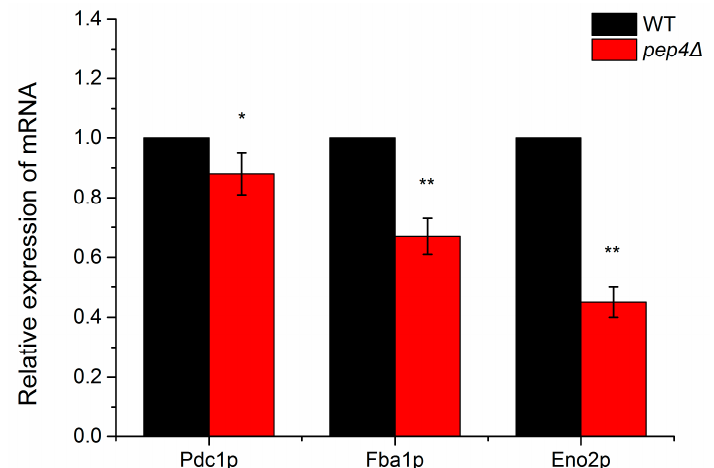
291 Figure 3. Relative mRNA expression levels of three identified down-regulated glycolytic metabolism enzymes in pep4 ∆ strain compared with the BY4741 (WT). The mRNA expression of the wild-type strain is set to 1, and the data represent means ± S.D. ( n = 3). * p < 0.05, ** p < 0.01 compared to